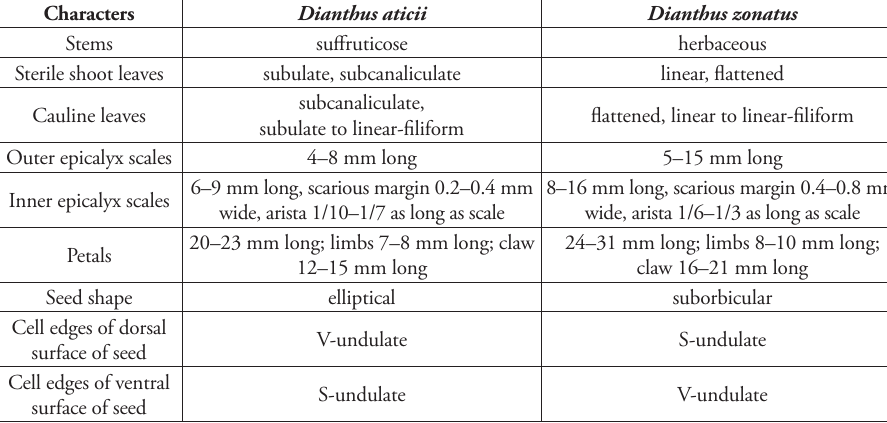
Table 1. Diagnostic characters between Dianthus aticii and D. zonatus